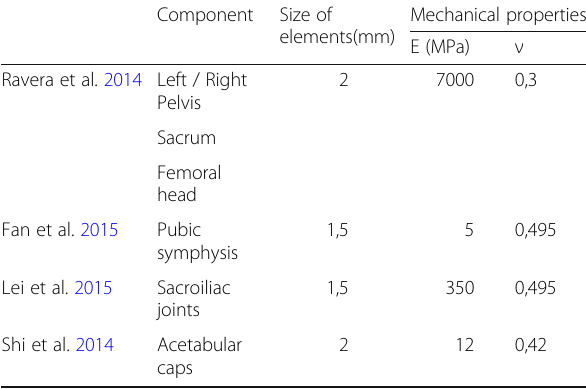
Table 1 Size of elements and mechanical properties of components